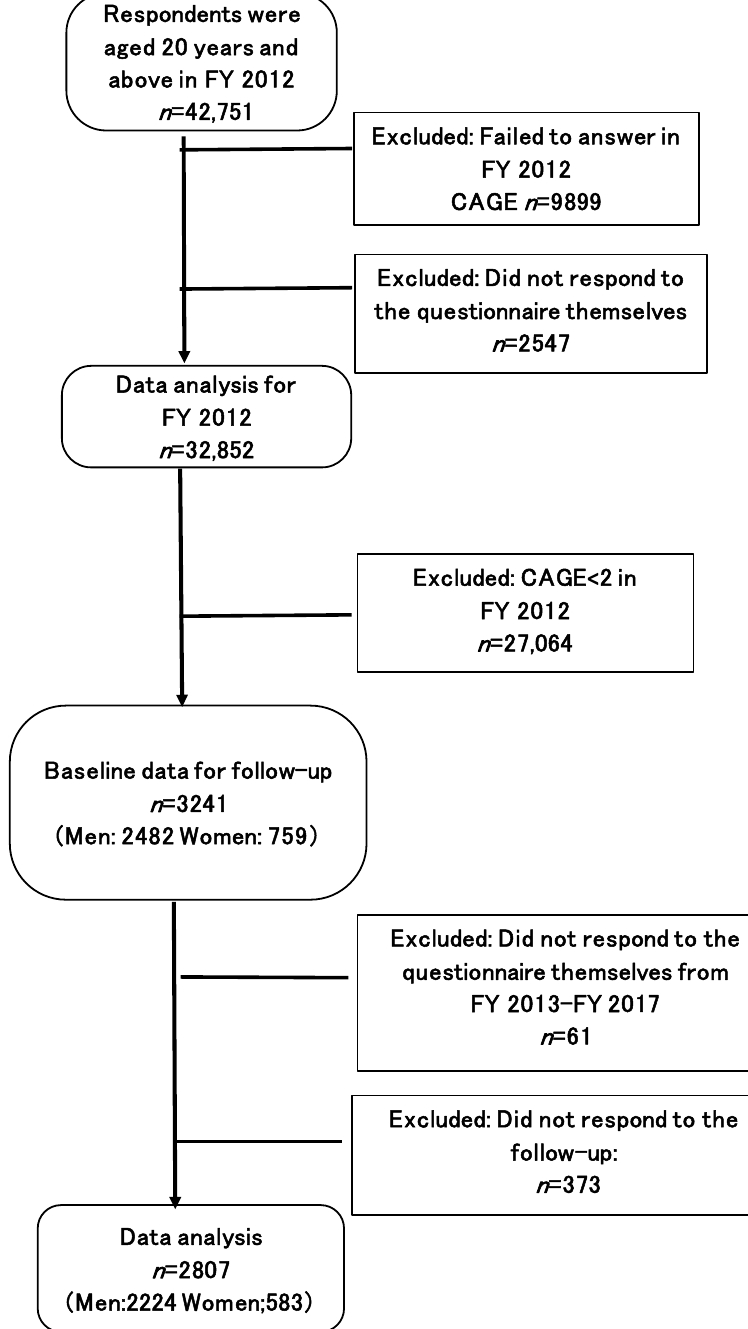
Figure 2. Participant flow chart (CAGE ≥ 2 in 2012).